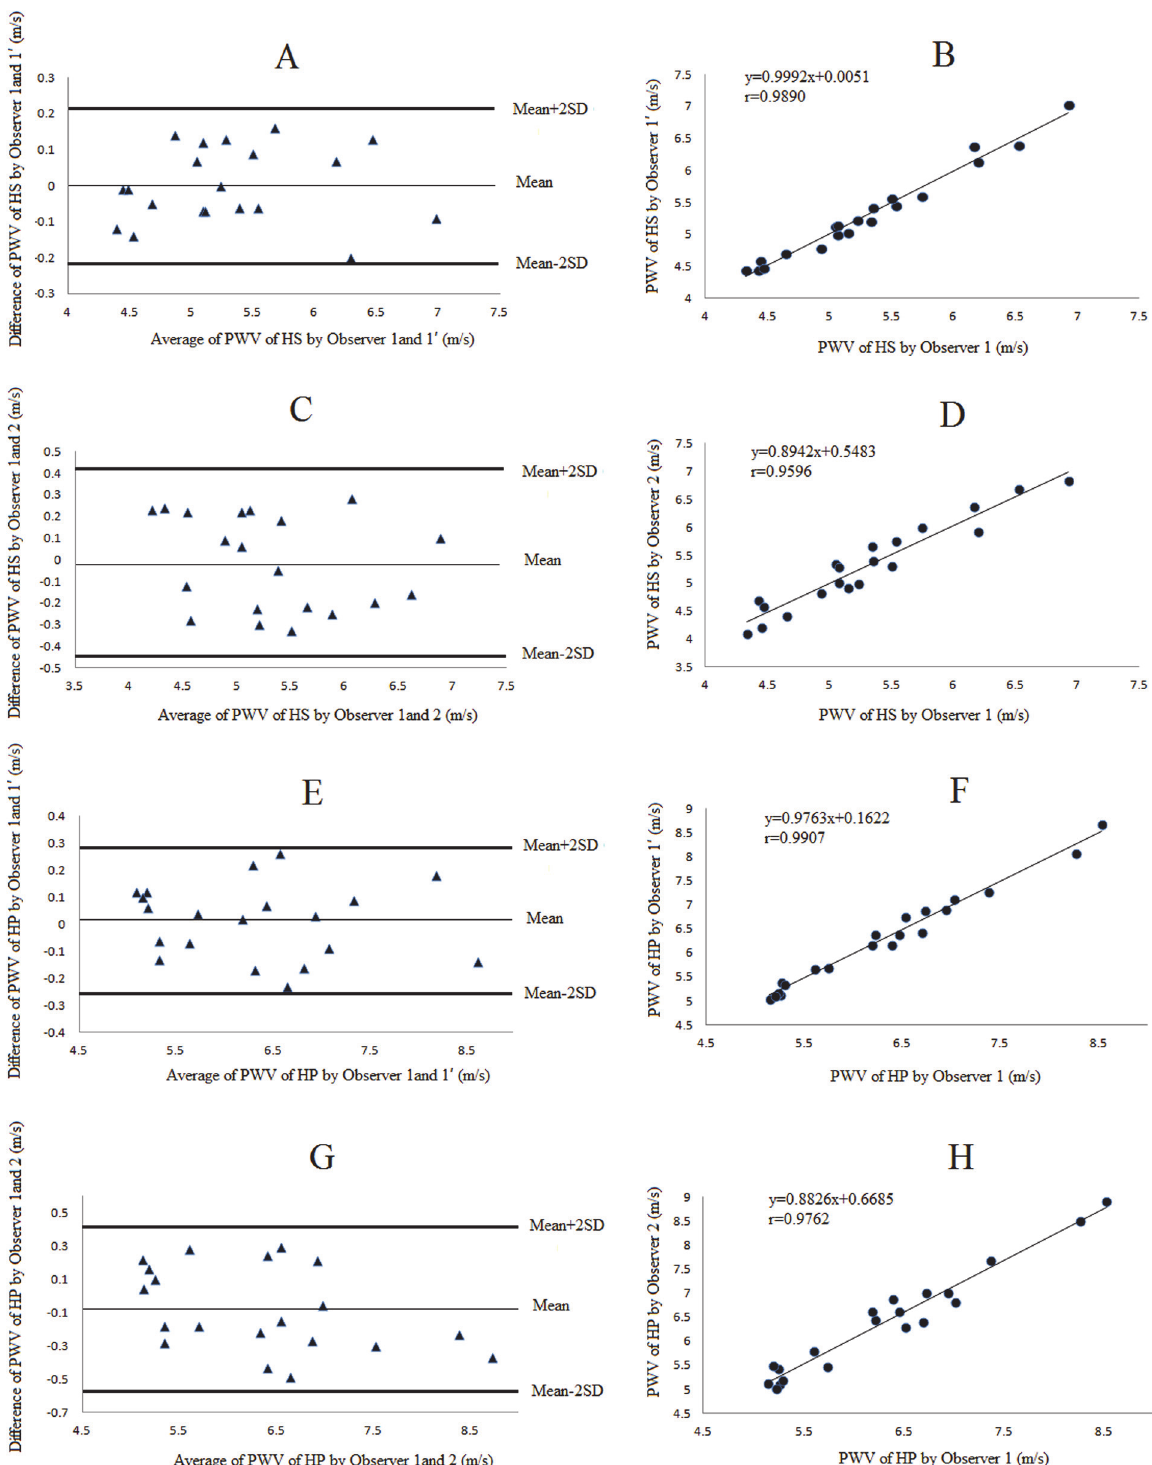
Fig 5. Intra- and inter-observer variability of the local PWV measurements in vivo. Intra- (A, B) and inter- (C, D) observer variability of local PWV measurements in healthy subjects (HS), intra- (E, F) and inter- (G, H) observer variability in hypertension patients (HP) were demonstrated by Bland-Altman plots and linear regression analysis,